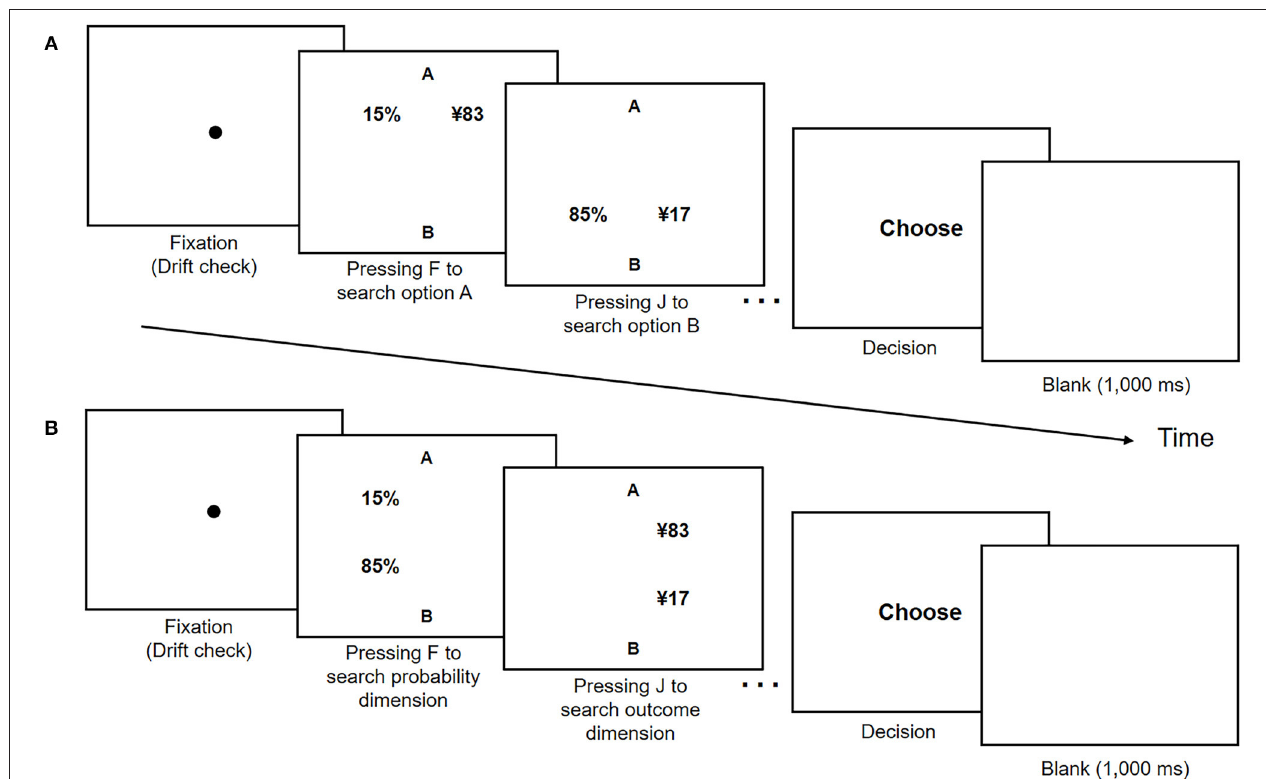
FIGURE 3 | Trial procedure and timing in (A) alternative- and (B) dimension-wise tasks in Experiment 2. Each trial began with each participant fixing their gaze at the middle of the screen. After registering their response, these participants were shown a blank screen at a 1,000 ms interval before proceeding to the next trial.